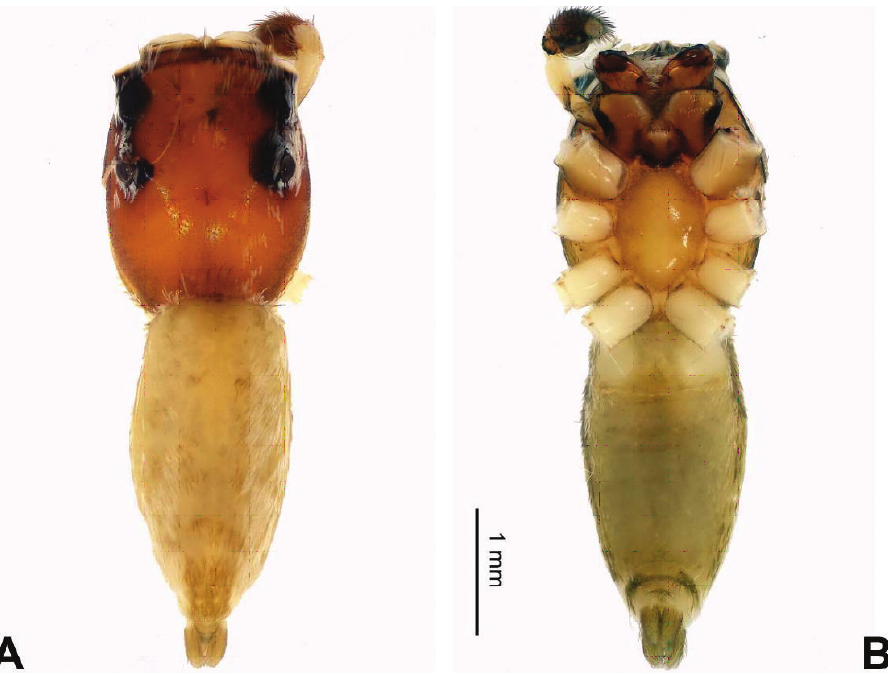
Figure 35. Habitus of Phintella sancha sp. n., male holotype. A dorsal B